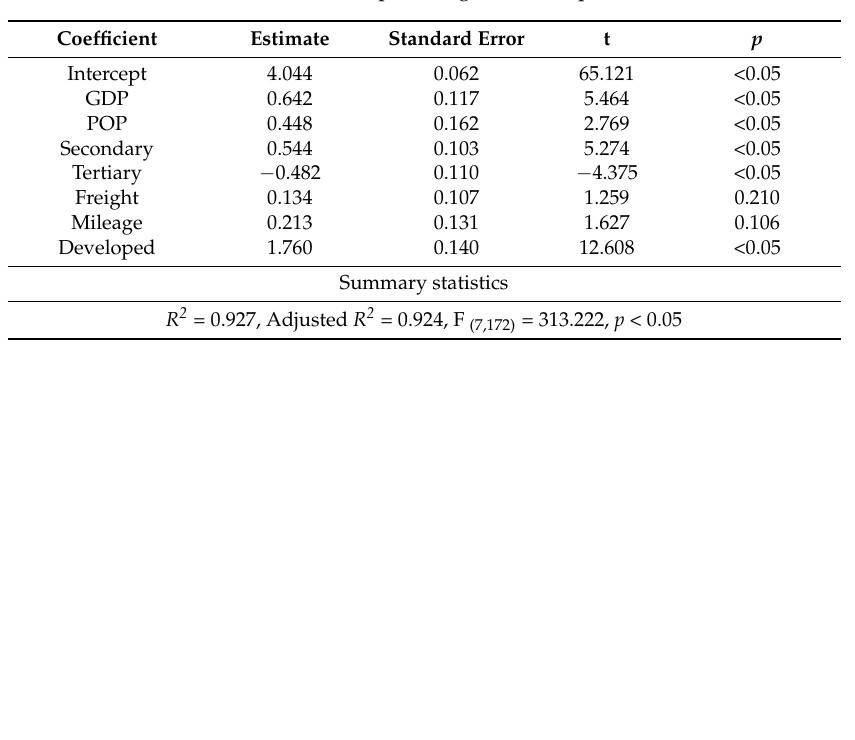
Table 4. Random effects estimator of the panel regression (dependent variable: